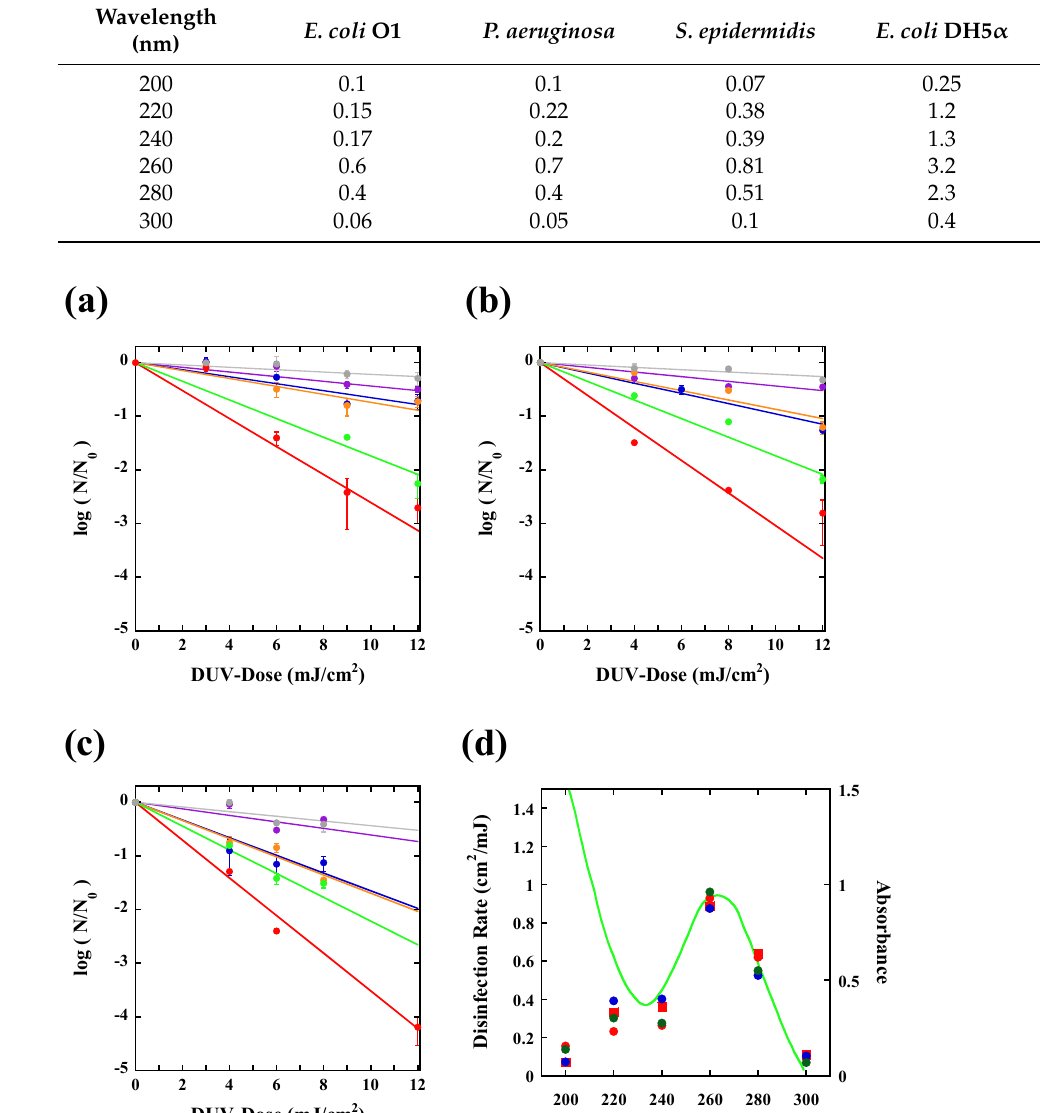
Table 1. Inactivation rate constants as a function of irradiation wavelength for E. coli O1, P. aeruginosa , S. epidermidis , and E. coli DH5 α .